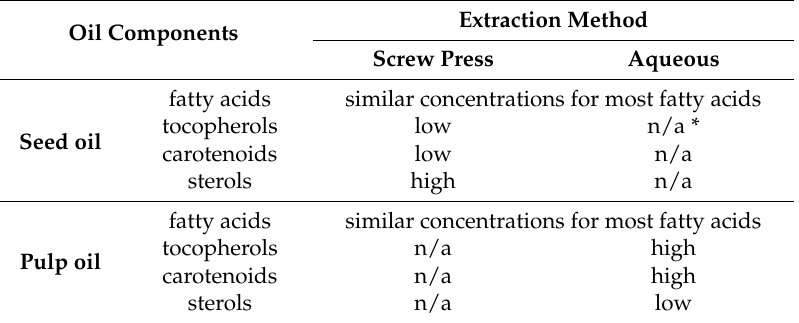
Table 2. The effect of screw press and aqueous extraction methods on changes of nutritional components in oils (the order of increasing concentration: low < high < highest).